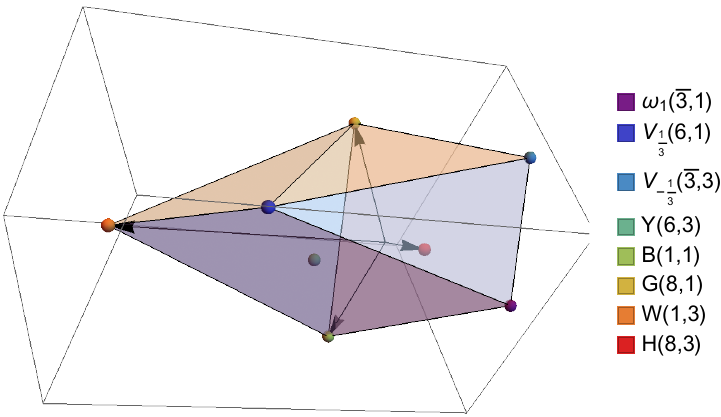
Figure 15. A slice of the positive cone in the space of ~C = ( C 1 , C 2 , C 3 , C 4 ) , defined by intersecting the entire cone with a 3-dimensional hyperplane. The colored dots represent the generators. 6 of them are ERs and define the polytope cone. The black arrows are the projections of the 4 basis operators on this